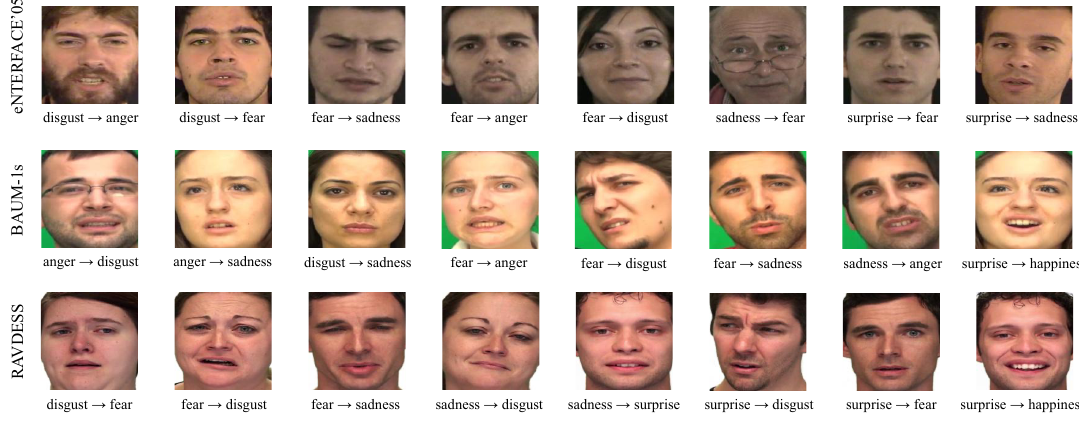
Figure 6. Some misclassification samples on the eNTERFACE’05, BAUM-1s, and RAVDESS datasets. For instance, the image on the left of the first row is marked with “disgust → anger”, which indicates that the true label of the input data is “disgust”, but our model predicts that its label is